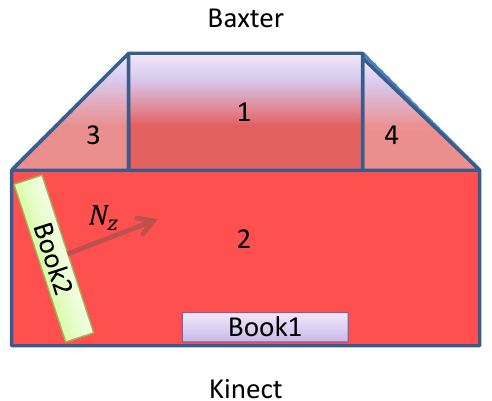
Figure 9. Labeling of the